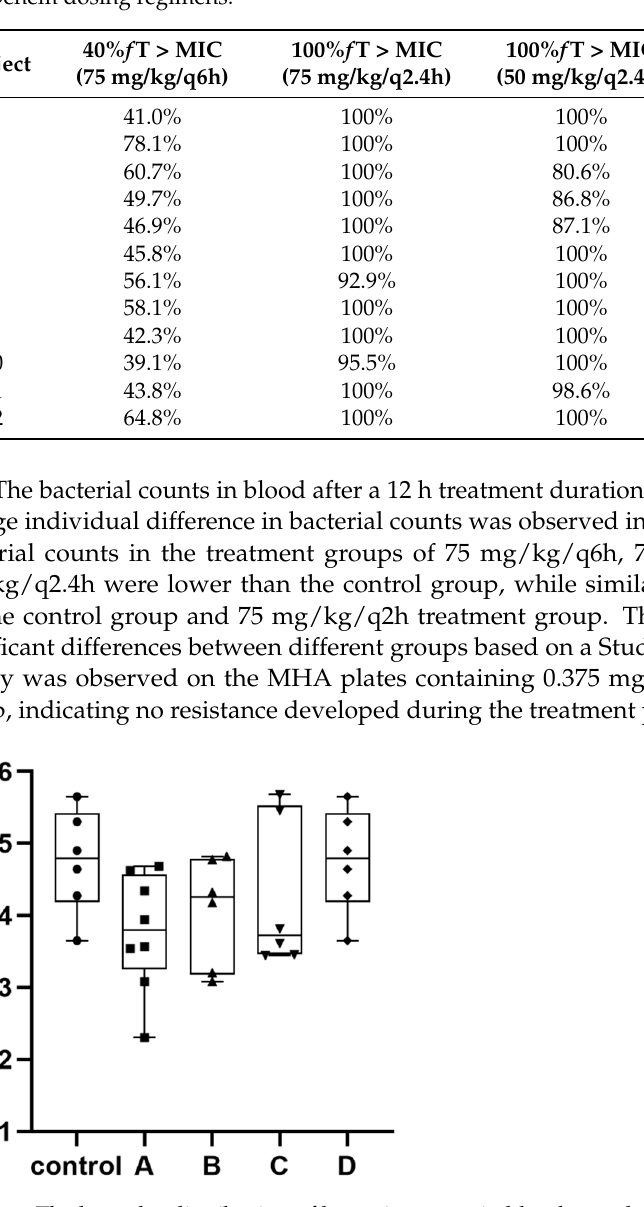
Figure 3. The box-plot distribution of bacteria counts in blood samples from sepsis rats following 12 h of treatment with meropenem. The dosing regimens for the treatment groups of A, B, C, and D were 75 mg/kg/q6h (40% f T > MIC), 75 mg/kg/q2.4h (100% f T > MIC), 50 mg/kg/q2.4h (100% f T > MIC), and 75 mg/kg/q2h (100% f T > 4 × MIC), respectively. The control group received equal volume of sterile